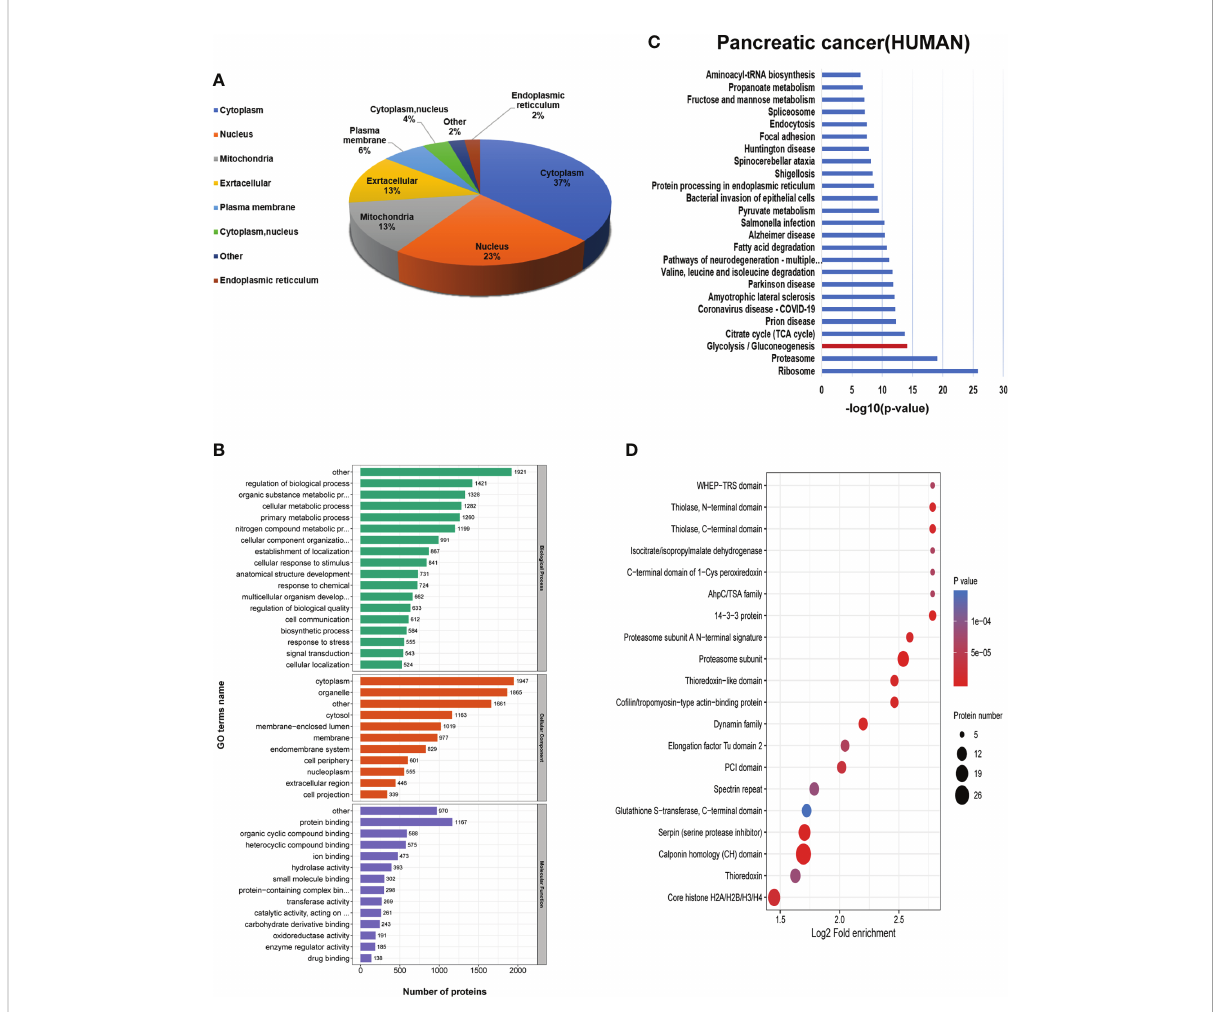
FIGURE 3 Bioinformatics analysis of the 2-hydroxyisobutyrylation (K hib ) proteins. (A) Subcellular localization of the K hib proteins. (B) Gene Ontology (GO) classi fi cation analysis of the K hib proteins based on the biological process, molecular function, and cellular component. (C) Kyoto Encyclopedia of Genes and Genomes (KEGG) pathway analysis of the K hib proteins. (D) Protein domain enrichment